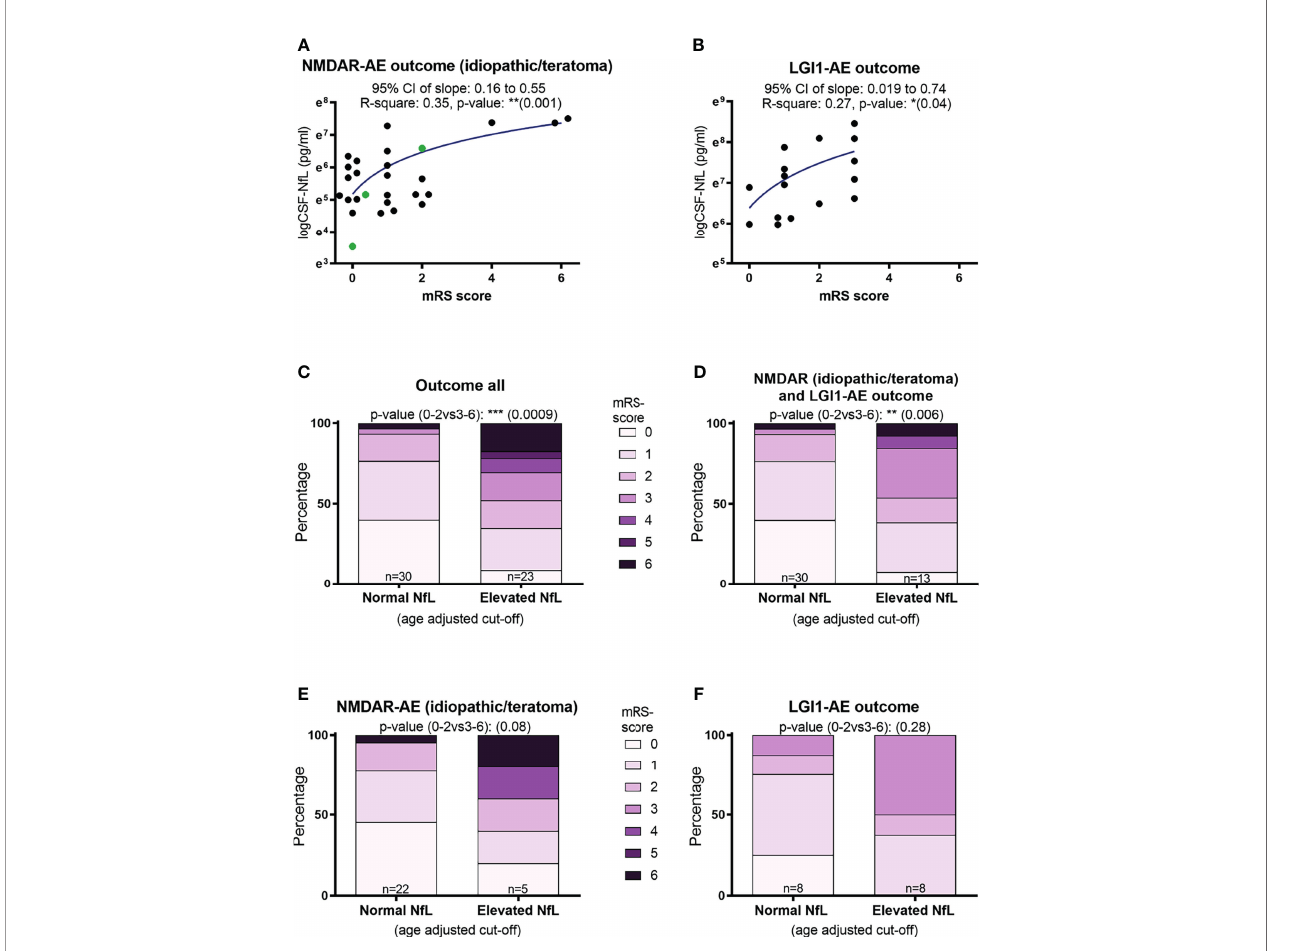
FIGURE 2 | CSF-Neuro fi lament light chain (NfL) levels at diagnosis and patient outcomes. Higher CSF-NfL values at diagnosis was associated with worse outcome at last follow-up in both NMDAR and LGI1-AE patients (A, B) . Applying age-adjusted cut-off values for elevated CSF-NfL, showed that elevated NfL at diagnosis was associated with a poorer outcome in both the complete cohort tested and in idiopathic/teratoma associated NMDAR- and LGI1-AE patients combined (C, D) . When further dividing the cohort into idiopathic/teratoma associated NMDAR-AE patients (E) and LGI1-AE patients alone (F) , patients with elevated NfL at diagnosis still showed a poorer outcome, but no longer signi fi cant. NMDAR-AE patients with teratomas are shown as green datapoints (A) . *p value < 0.05, **p value < 0.01, ***p value <